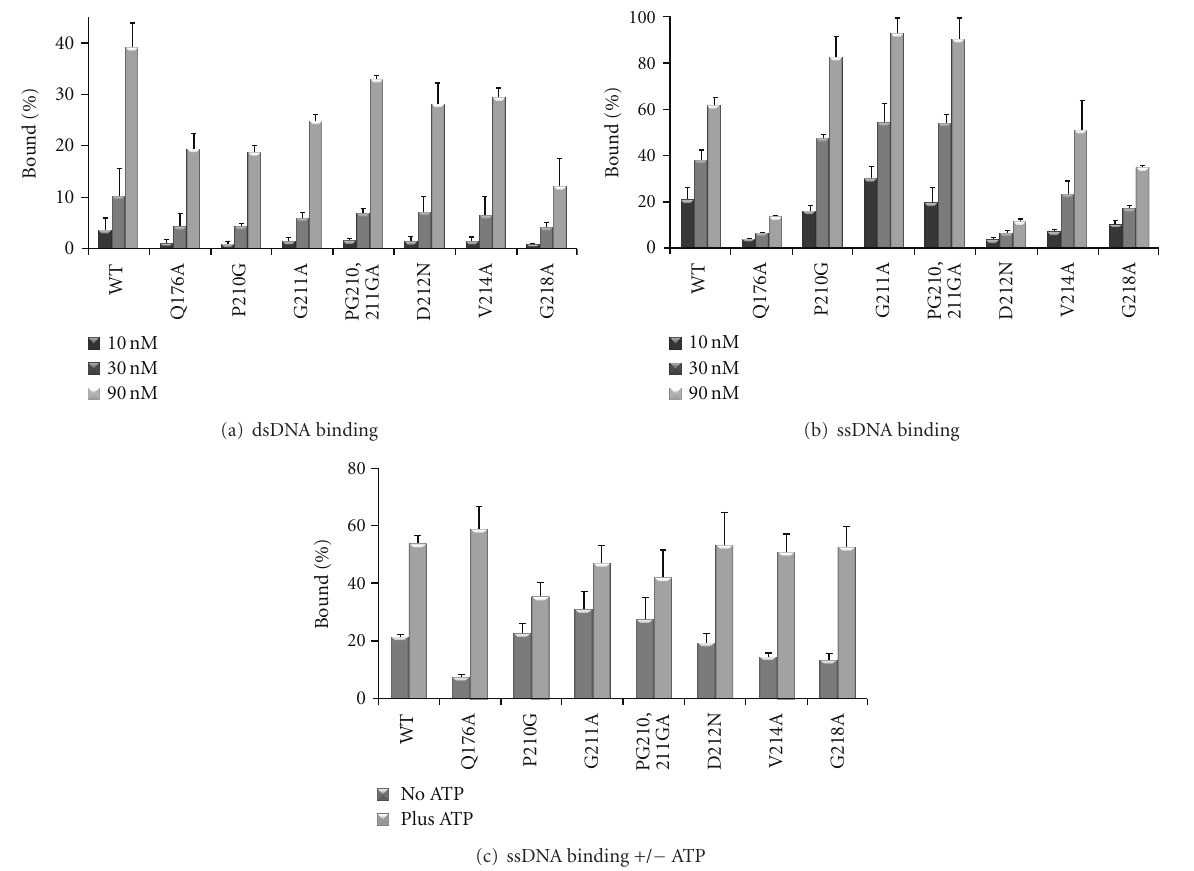
(b) ssDNA binding